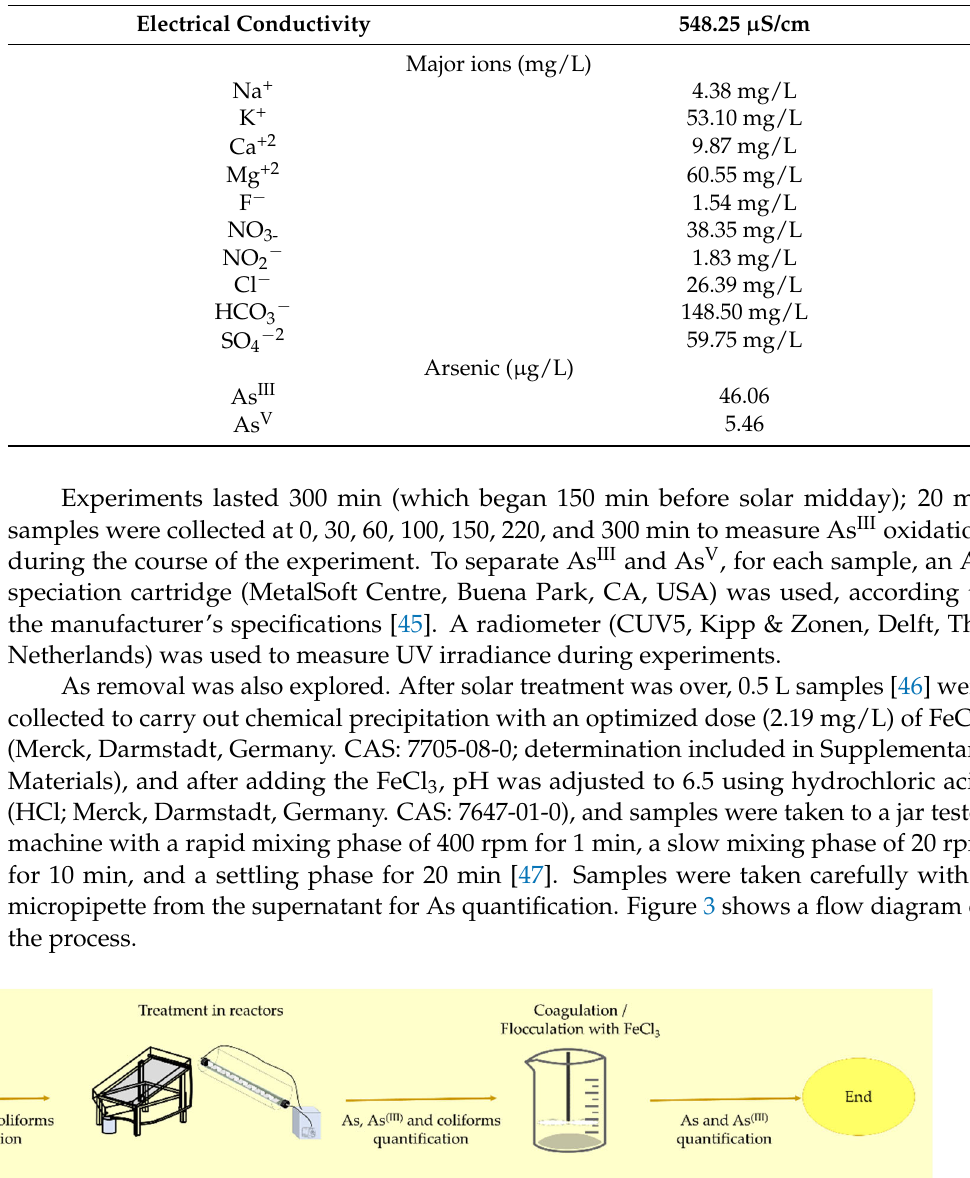
Table 2. Groundwater physicochemical characterization.